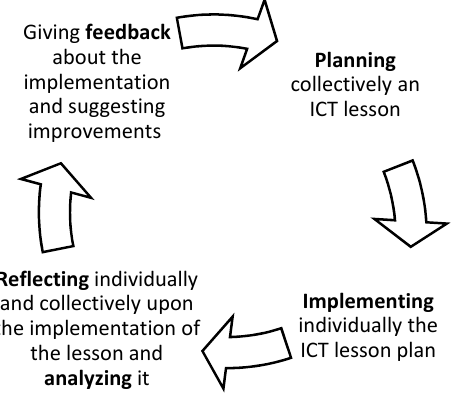
Figure 6. The inquiry cycle processes.